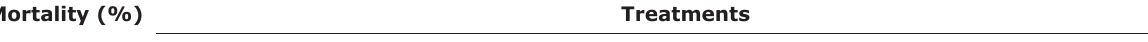
Table-1: Mortality rate of broiler Japanese quails up to 5 weeks of age. Mortality (%)